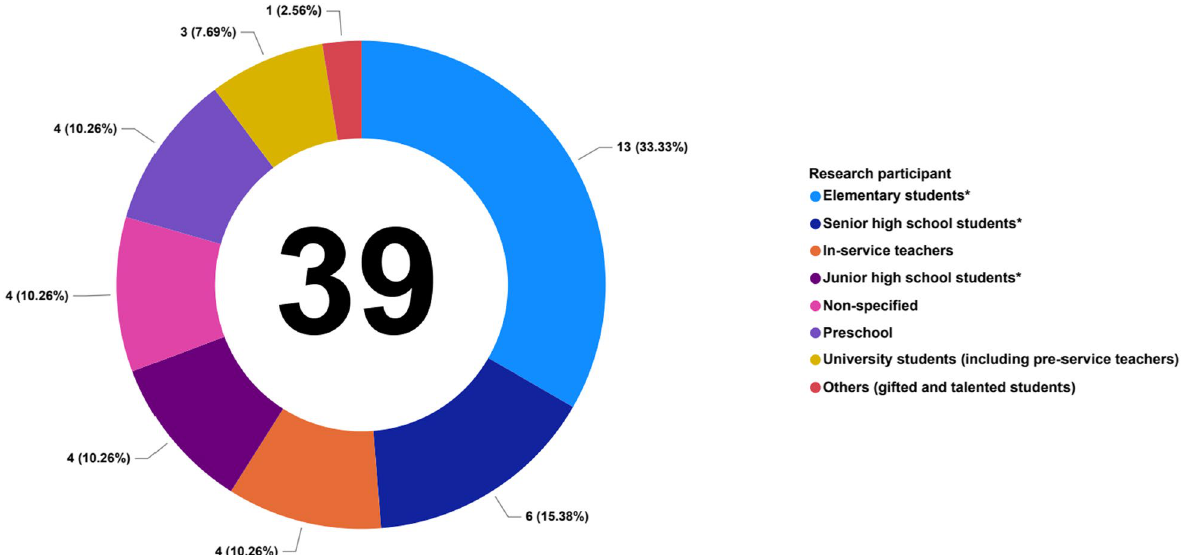
Fig. 8 Frequency of research participants in the selected period